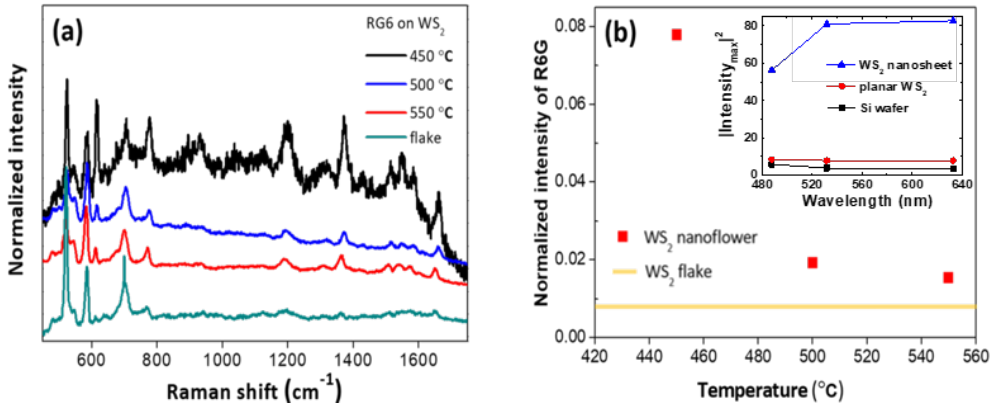
Figure 7. ( a ) Raman spectra of R6G molecules adsorbed on WS 2 nanosheets substrates grown at 450, 500, and 550 ◦ C, and an exfoliated WS 2 monolayer flake sample. Spectra are o ff set for clarity. Intensities are normalized to the intensity of WS 2 E 1 2g mode. ( b ) Normalized (to WS 2 E 1 2g mode) intensity of R6G 1361 cm − 1 mode. Filled squares represent the normalized intensities observed from WS 2 nanoflower (nanosheet) samples, and the straight line represents the normalized intensity observed from an exfoliated WS 2 monolayer flake. Inset: Finite-di ff erence time-domain (FDTD) calculation results of scattered electric field intensity squared as a function of incident wavelength. Note that scattered intensities from both WS 2 samples are larger than that from Si wafer confirming that it is from surface-enhanced Raman scattering (SERS) e ff